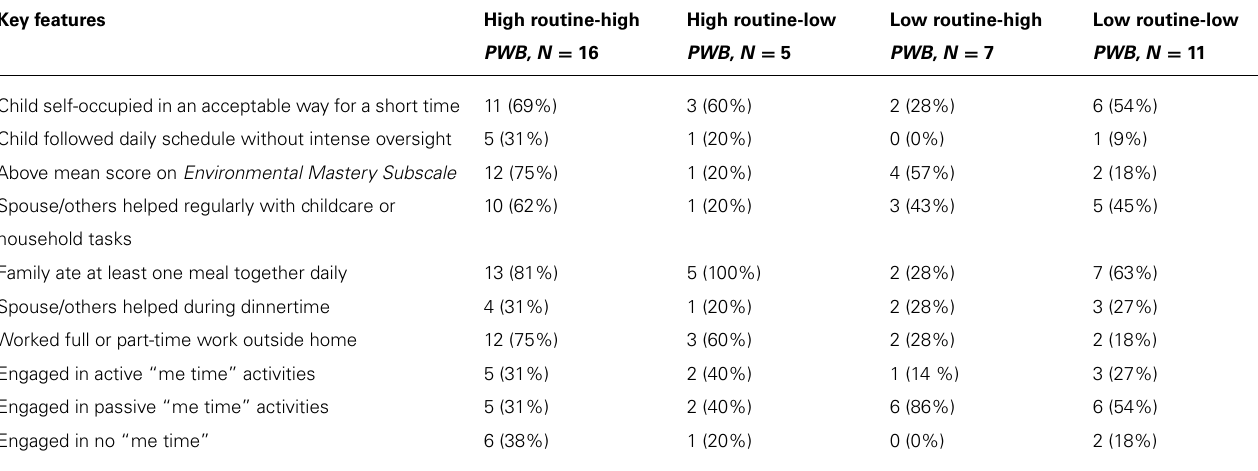
Table 2 | Comparison of number and percentages of caregivers with key ecological features by